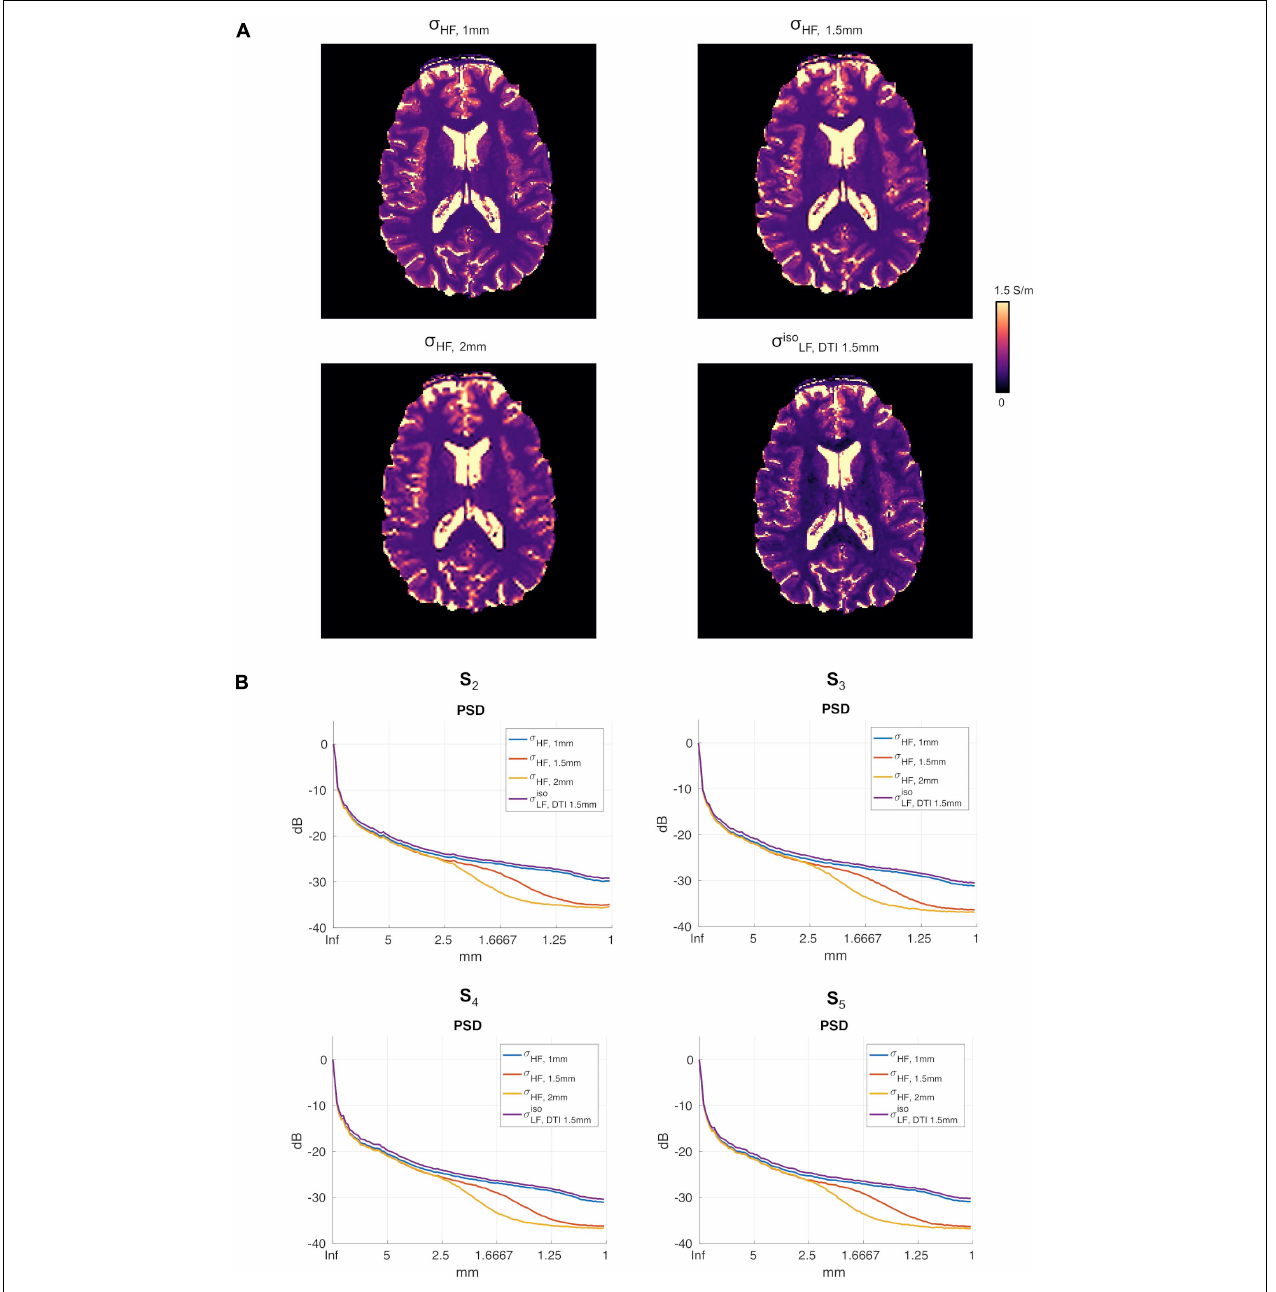
FIGURE 6 | (A) Conductivity maps in subject S5 for σ HF , 1 mm , σ HF , 1 . 5 mm , σ HF , 2 mm and σ iso LF , DTI 1 . 5 mm in the apical regions of the brain. (B) σ HF , 1 mm , σ HF , 1 mm , σ HF , 2 mm , σ iso LF , DTI 1 . 5 mm PSDs for subjects S2 to